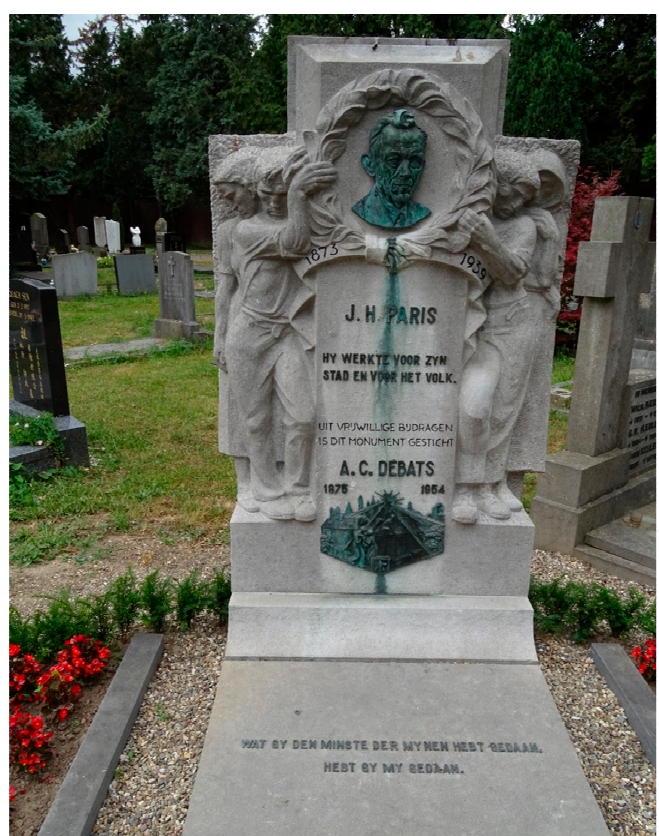
Figure 5. Grave of Socialist leader J.H. Paris (photograph: C.J.).